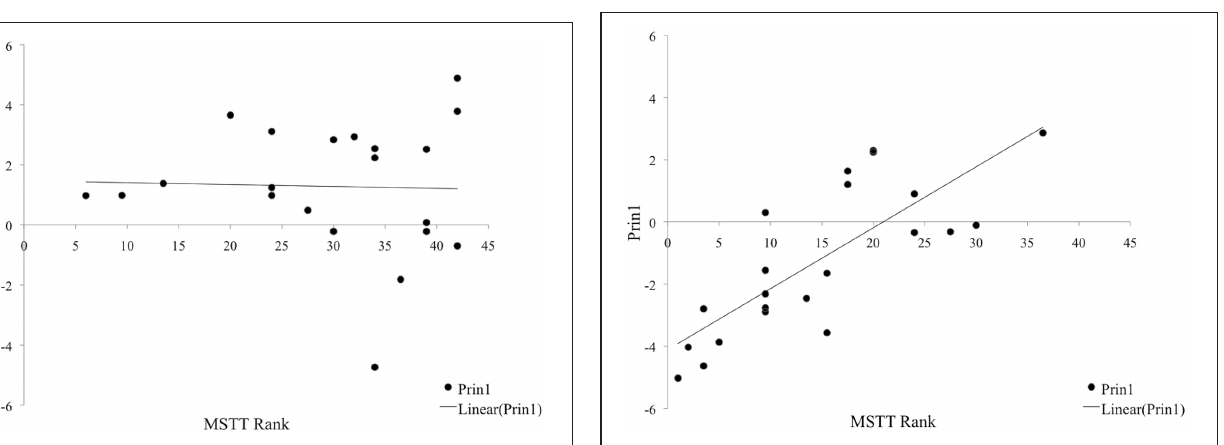
FIGURE 2 | Relationship of Prin 1 to MSTT in children with no SR or IR. FIGURE 3 | Relationship of Prin1 to MSTT in children with